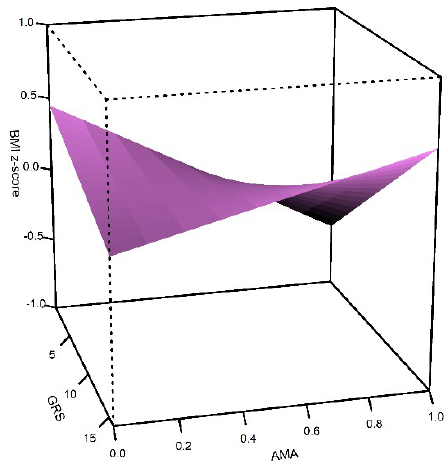
Figure 1. Effect of genetic risk score (GRS) and Amerindian ancestry (AMA) on body mass index z-score (BMI z-score) in Northern and Central Mexican children. Three-dimensional surfaces show the interactions among the explanatory variables in the Generalized Linear Model for BMI.